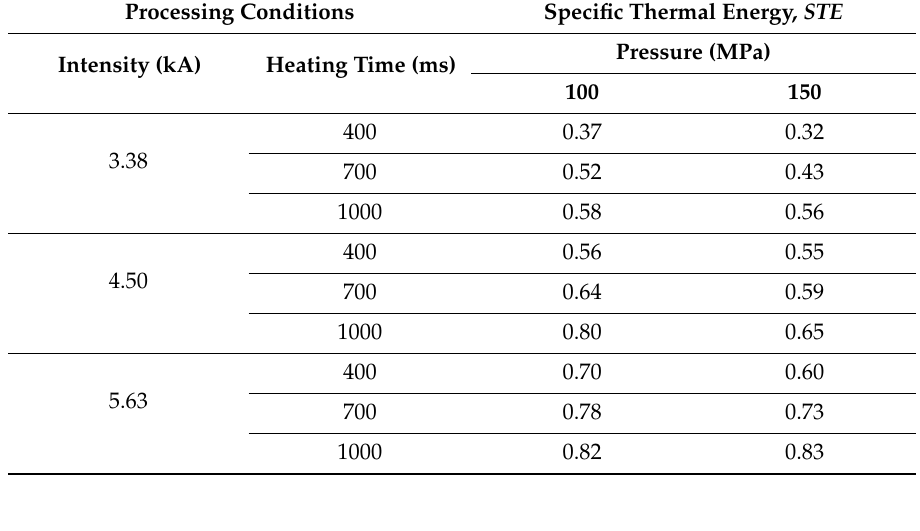
Table 2. Specific thermal energy ( STE ) values (expressed in kJ / g) for the di ff erent MF-ERS experiments. Processing Conditions